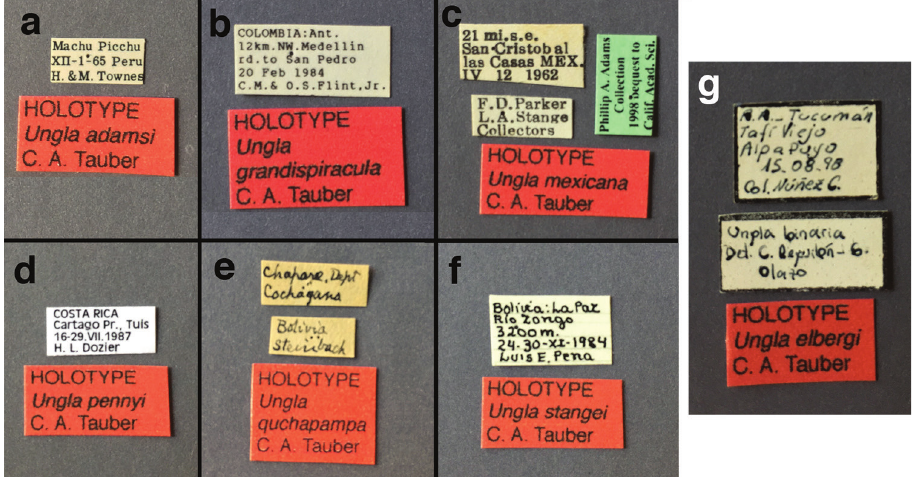
Figure 144. Type labels from Ungla species described in this study, a–f species from northern South America ( g ) species from southern South